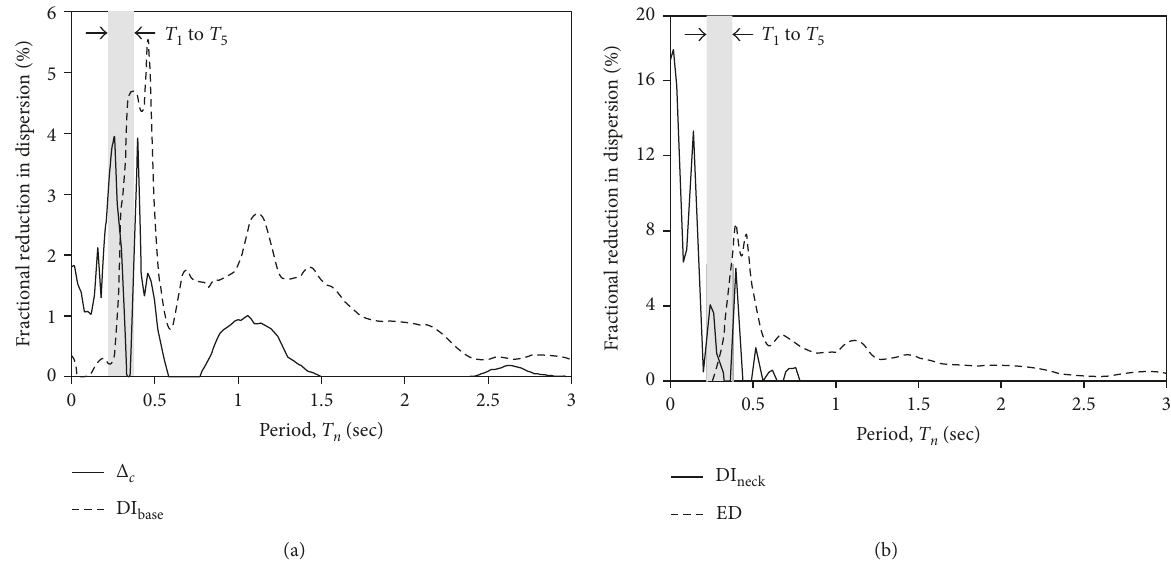
Figure 7: Fractional reduction in dispersion in terms of T n for EDP as (a) Δ c and DI base and (b) E D and DI neck . The first element of the vector IM is S a ( T 1 ), and the second element is Ψ 1, n � S a ( T n )/ S a ( T 1